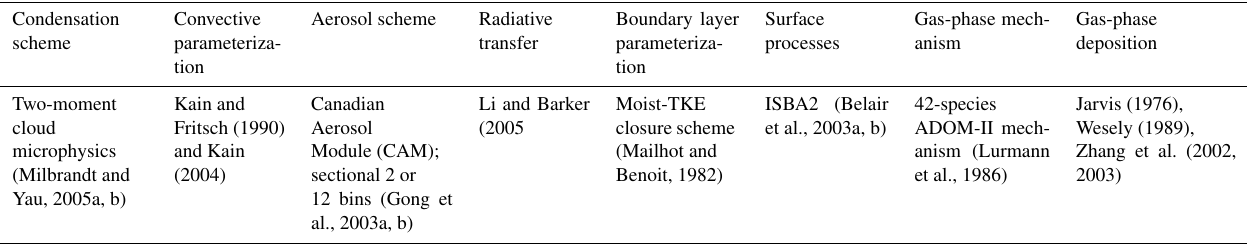
Table 1. A summary of the main physical and chemical processes represented in the GEM-MACH regional model. Condensation